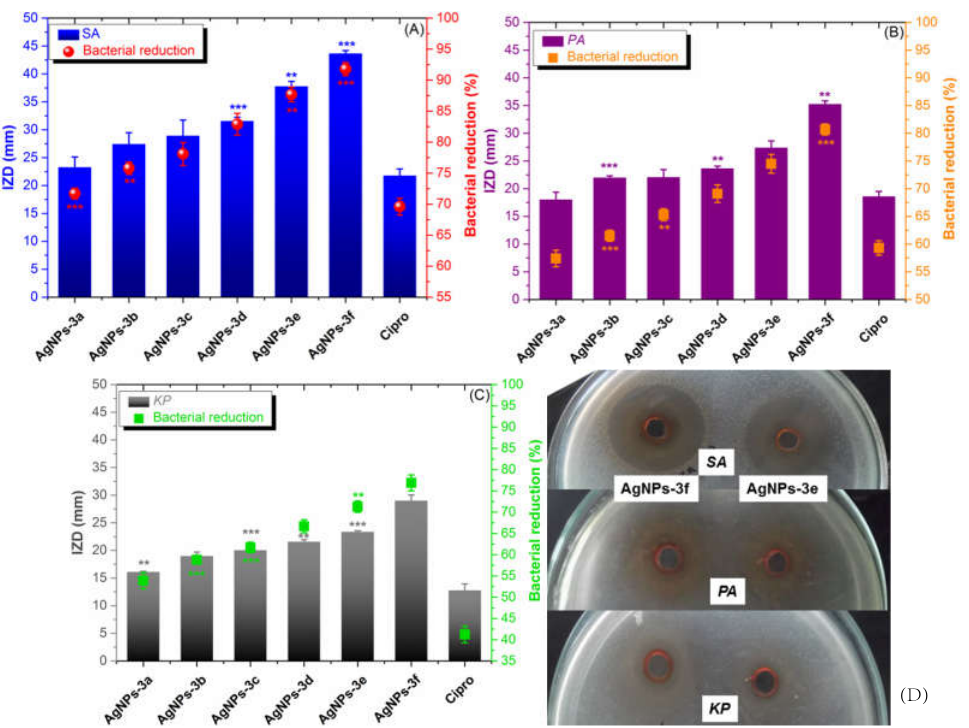
Figure 6. Graph for the inhibition zone diameter (IZD, mm) and the percentage of bacterial colonies reduction (%) for the examined AgNPs against ( A ) G + bacteria ( SA ), ( B ) G − bacteria ( PA ), and ( C ) G − bacteria ( KP ) (** p < 0.005, *** p < 0.001). ( D ) Photographs of inhibition zones for the most active antibiotics ( AgNPs-3e and AgNPs-3f ).